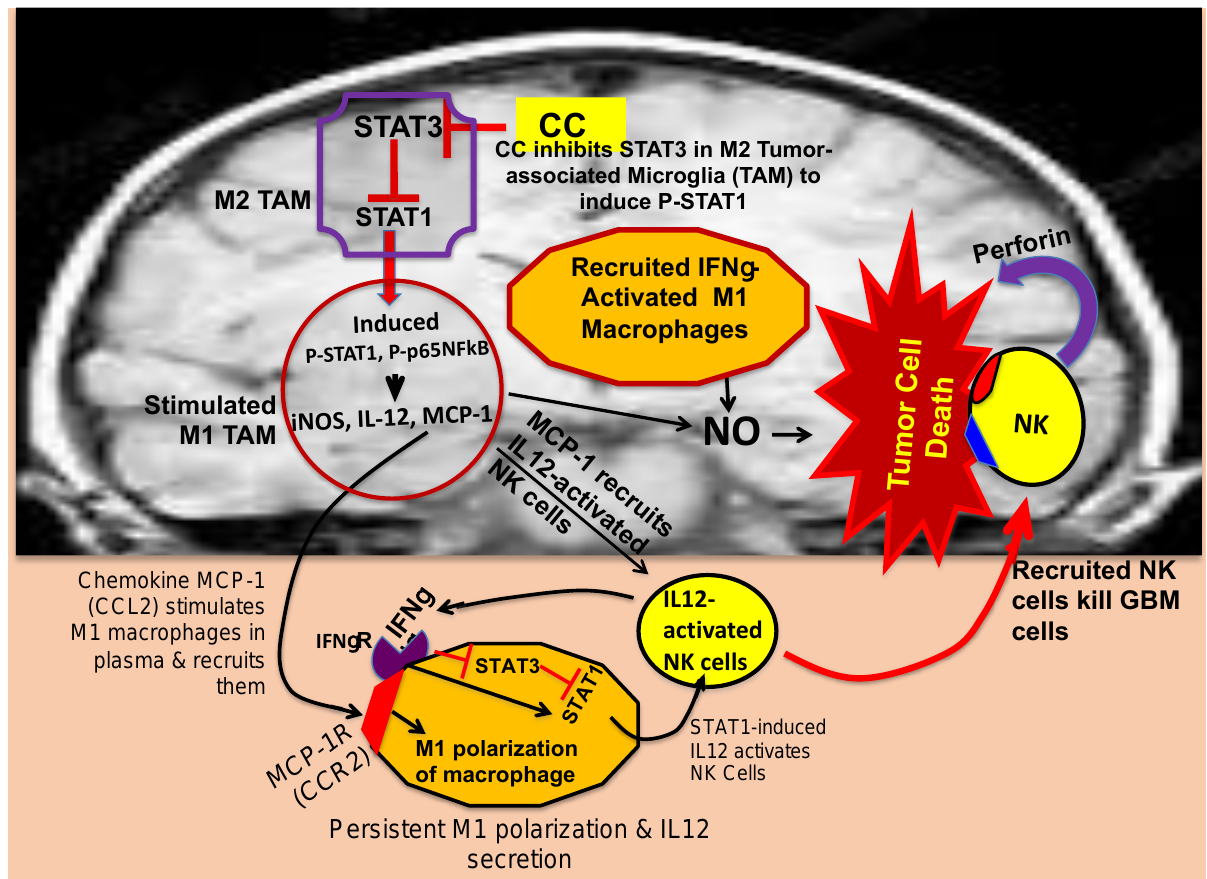
Figure 2. Proposed mechanism of M2 → M1 repolarization of TAM, recruitment of NK cells, and elimination of GBM cells and GBM stem cells.